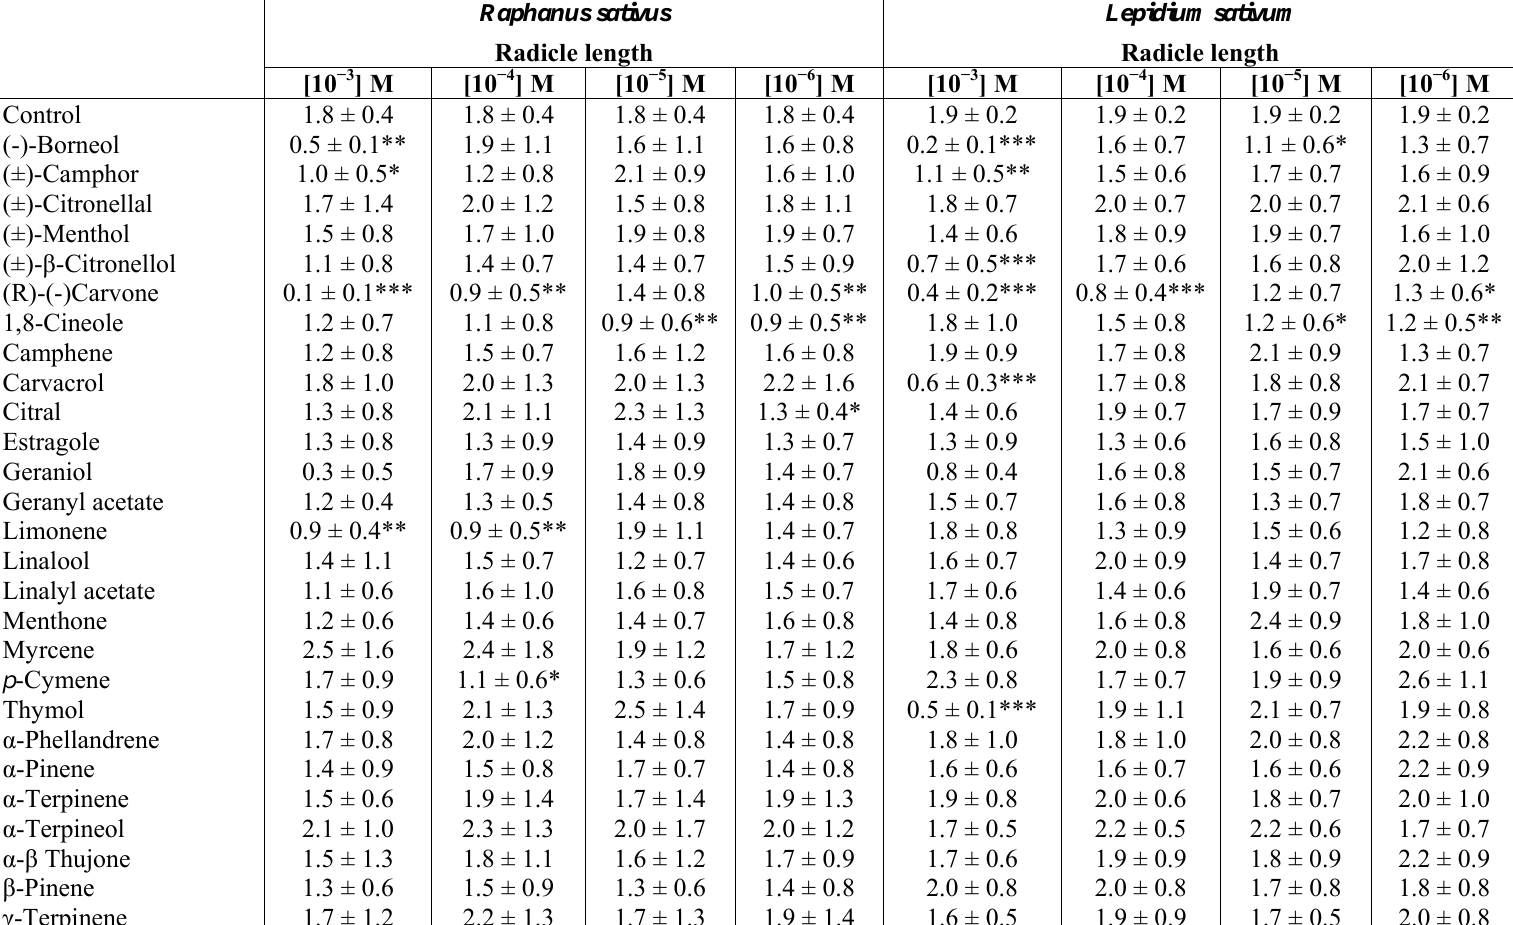
Table 2. Effects of different concentrations of monoterpenes on radish and garden cress radical elongation, 120 hours after sowing. The data are expressed in cm as the mean of three replicates ±